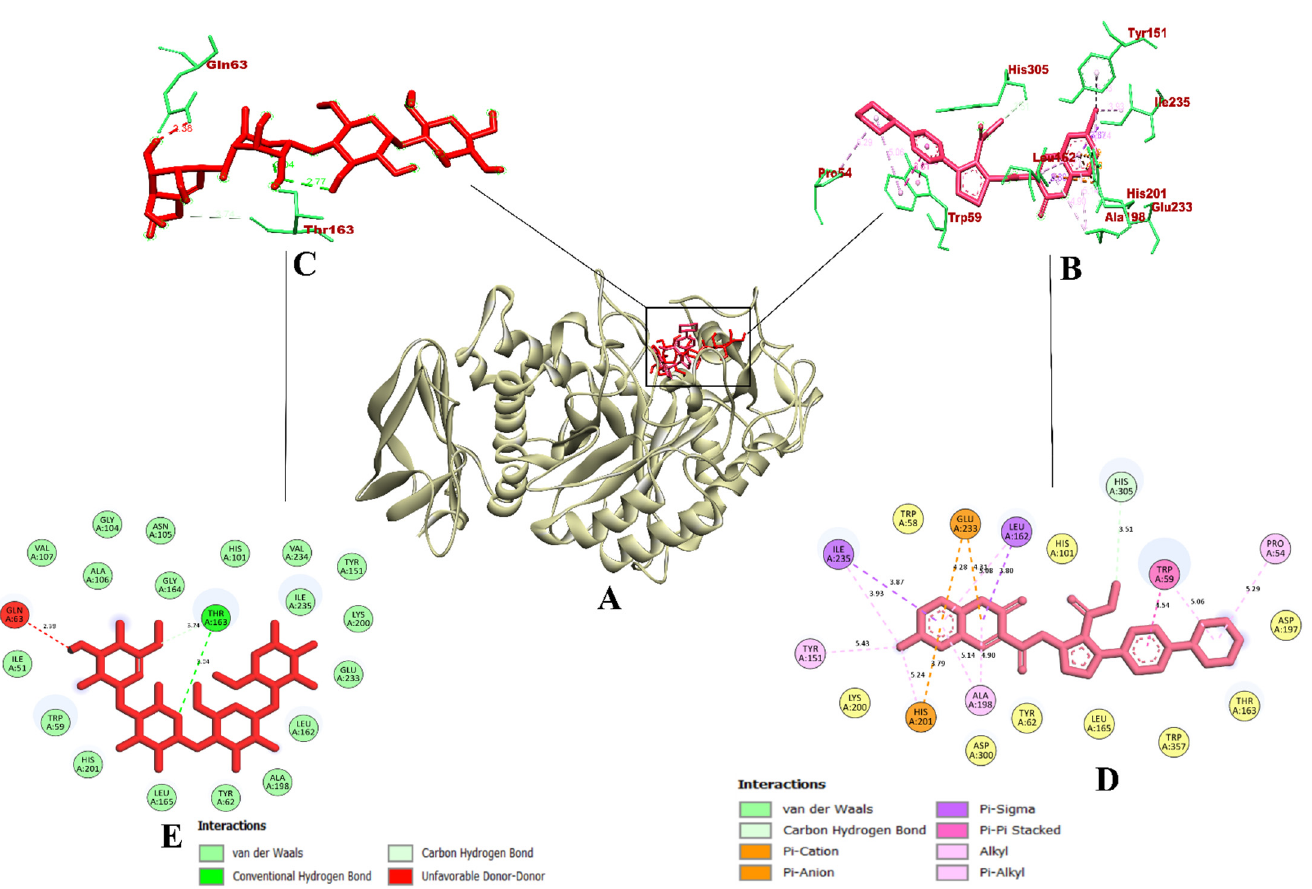
Figure 8. Visualization of binding interaction of ZINC02789441 (magenta) and acarbose (red) with α -amylase; ( A ) 3D structure of α -amylase with bound ZINC02789441 and acarbose in the binding pocket, ( B ) 3D representation of ZINC02789441 binding interactions, ( C ) 3D representation of acarbose binding interactions, and ( D ) 2D representation of CD-59 binding interactions, and ( E ) 2D representation of acarbose binding interactions. Colored: bound residues, yellow: surrounding residues.